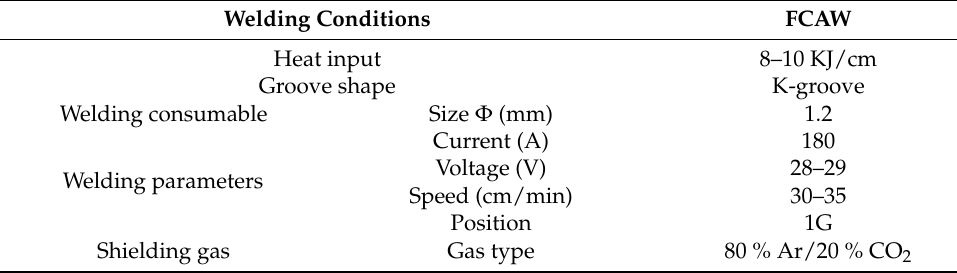
Table 3. Welding conditions.